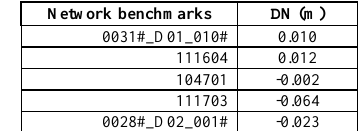
-0.023 Table 8: Differences between the undulation derived from benchmarks and from the IGM grid 273.gr2